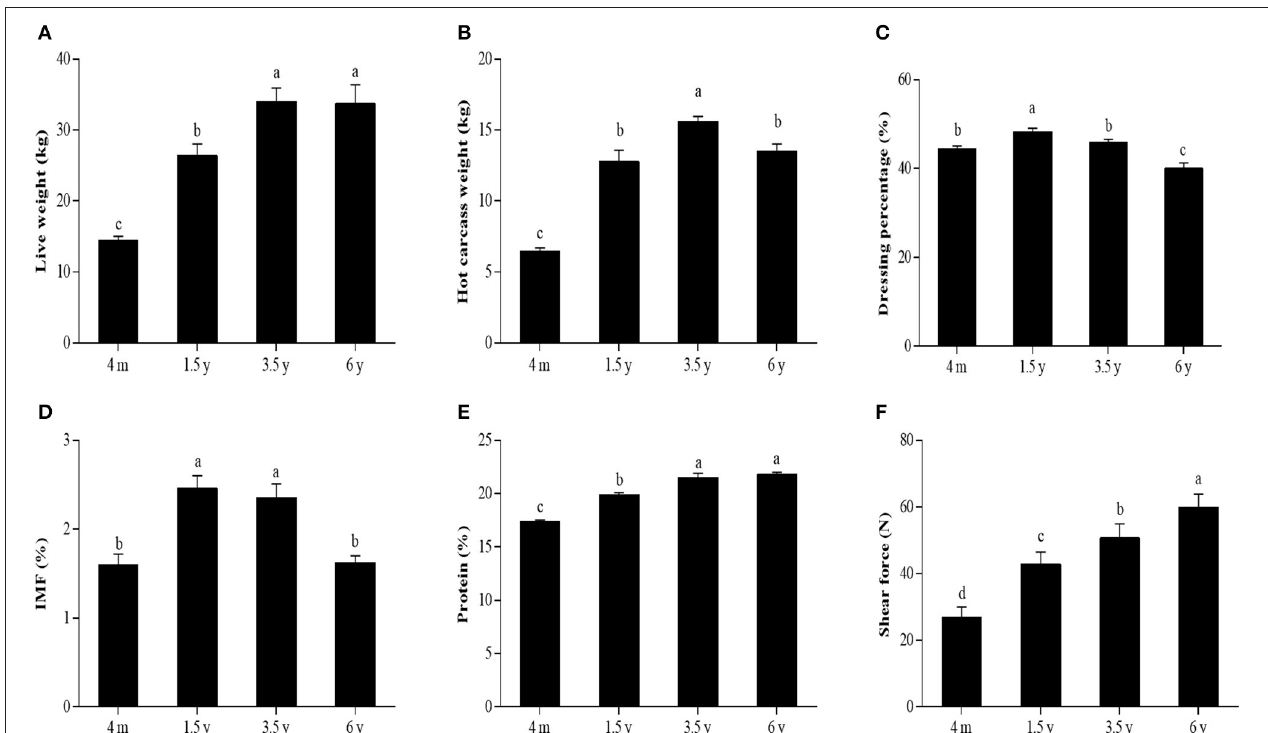
FIGURE 1 | The slaughter performance and meat quality of Tibetan sheep at different stages. (A) Live weight. (B) Hot carcass weight. (C) Dressing percentage. (D) IMF content. (E) Protein content. (F) The shear force of LT muscle of Tibetan sheep at 4m, 1.5 y, 3.5 y, and 6 y. Data were represented as the means ± SD. Different letters (a–d) indicated significant difference between the different age groups ( p <